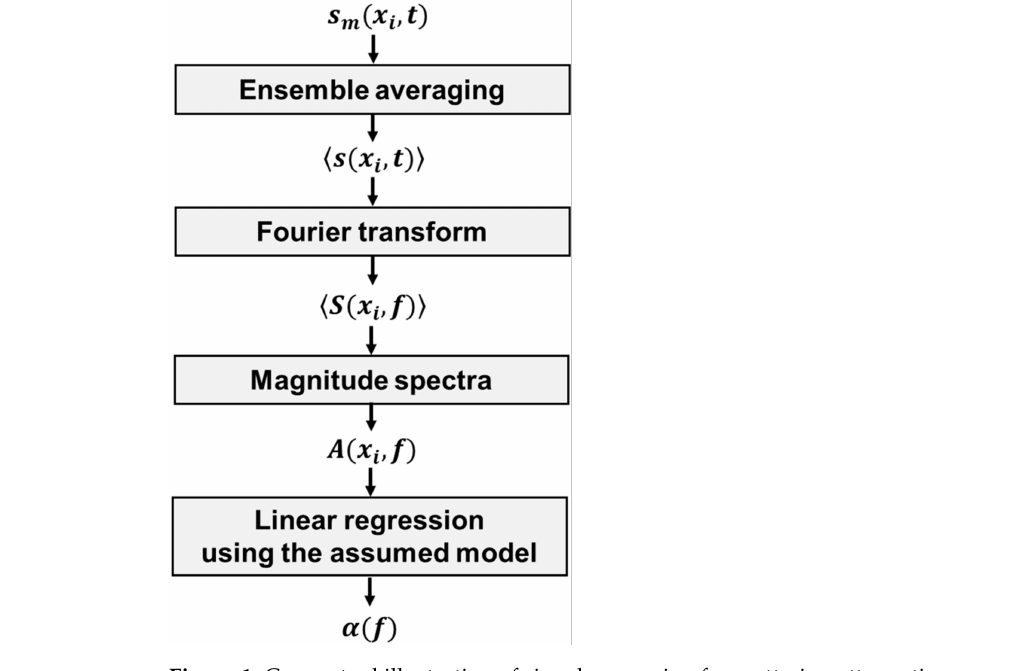
Figure 1. Conceptual illustration of signal processing for scattering